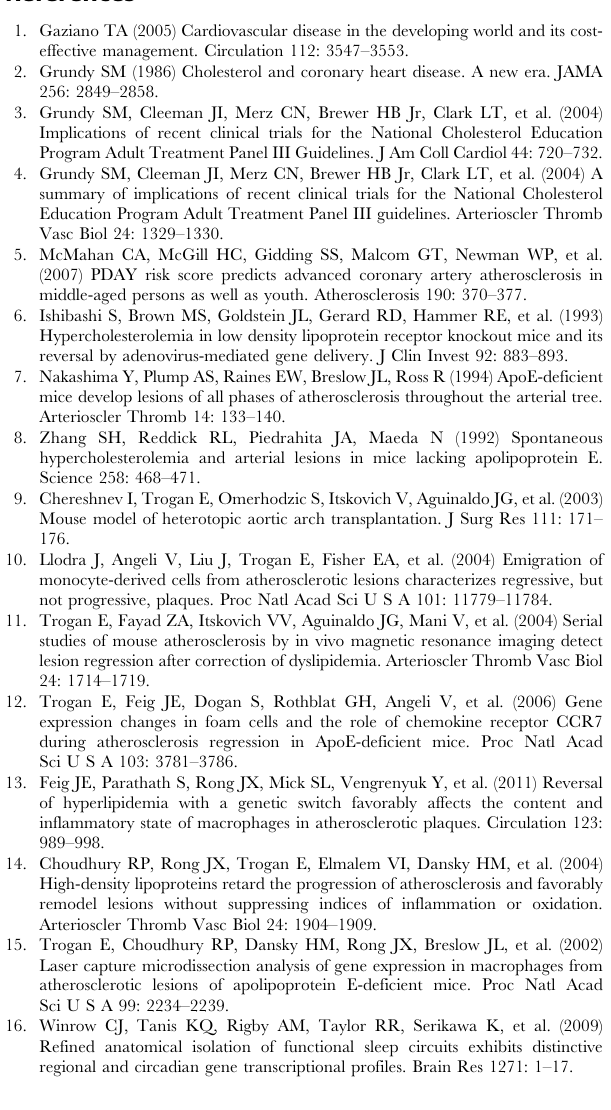
Table S4 Genes in selected biological